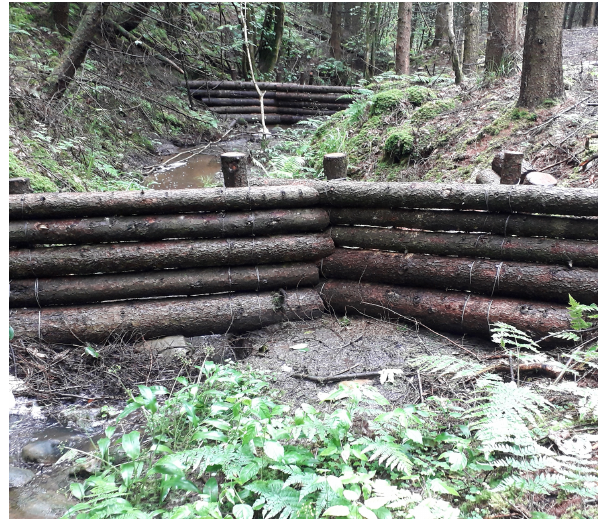
Figure 1. Leaky barriers in sequence in Penny Gill, Cumbria (Barry